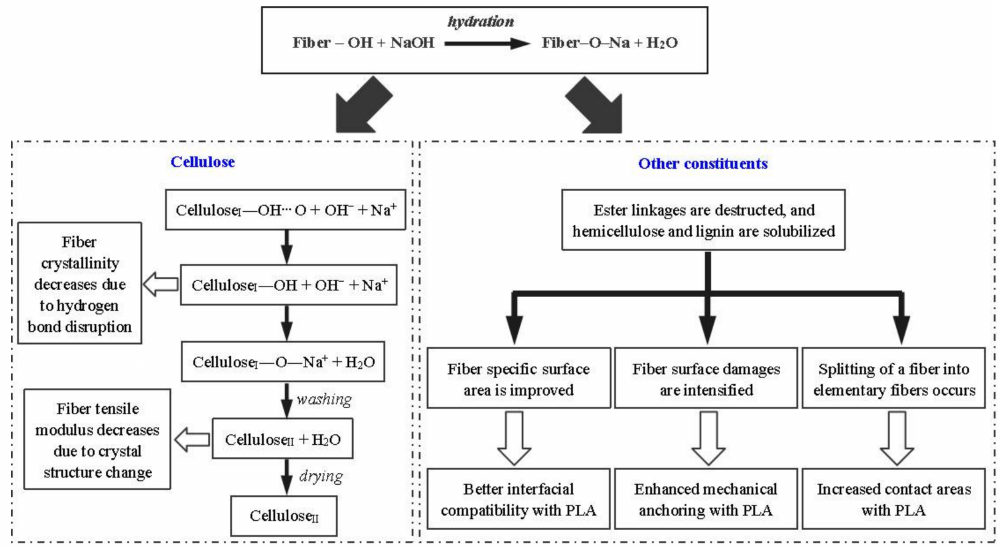
Figure 2. Reaction mechanism of alkali treatment.